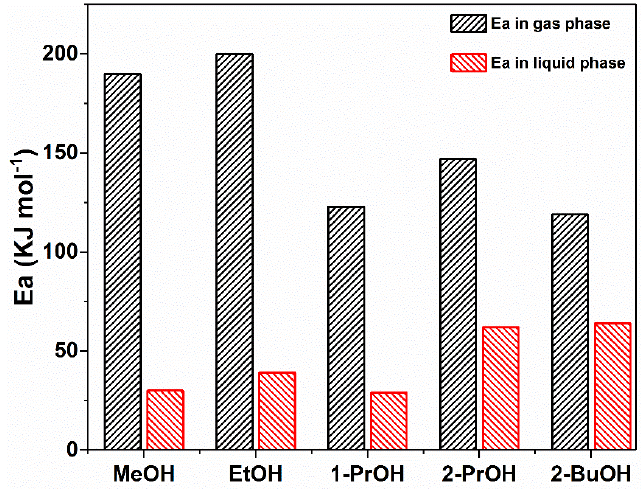
Figure 4. Apparent activation energy (Ea) of alcohol oxidations in gas and liquid phases over 4 nm Pt/MCF-17 (4.5 nm Pt/MCF-17 for 1-PrOH oxidation). Gas phase reaction: 1.33 kPa alcohol, 6.67 kPa O 2 , 94.66 kPa He; Liquid phase reaction: 15 mL alcohol, dissolved oxygen under 100 kPa for MeOH, EtOH, 1-PrOH, 2-PrOH, and 300 kPa for 2-BuOH. (Ea data for MeOH, EtOH, 1-PrOH, 2-PrOH, 2-BuOH oxidations were reported in [9,19–22],